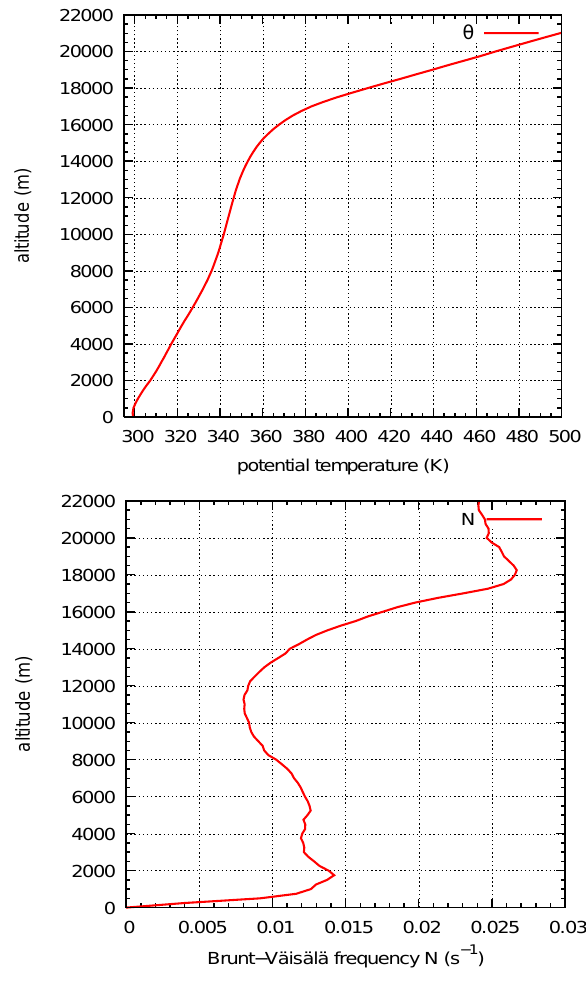
Fig. 5. Mean climatological vertical profiles in the tropical atmo- sphere as derived from measurements (Thompson et al., 2003); top: potential temperature, bottom: Brunt–Väisälä